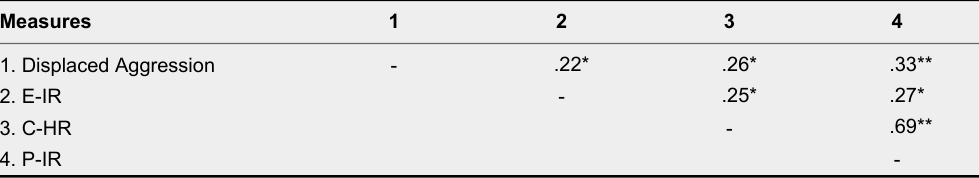
Pearson r Correlation Indices Between Readiness for Aggression and Displaced Aggression 4321Measures